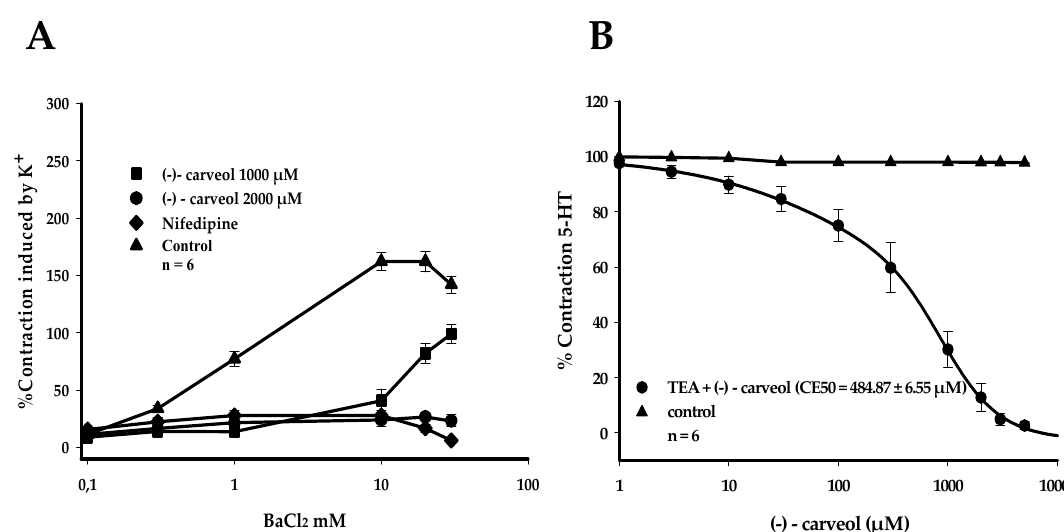
Figure 3. Relaxant effect of ( − )-carveol on HUA and evaluation of the participation of voltage- operated calcium channels (VOCCs) and large conductance Ca 2+ activated K + channels (BKCa). ( A ) Effect of ( − )-carveol (1000 and 2000 µM) on contractions evoked by exogenous BaCl 2 , where nifedipine (1 µM) was used as a positive control. ( B ) Representative graph of the effect of ( − )-carveol on contractions sustained by 5-HT (10 µM) in HUA sections pre-incubated with TEA (10 mM). Values are expressed as the mean ± SEM; n = 6 ( p < 0.05, one-way ANOVA followed by Holm–Sidak). Please correct the unit in the Figure